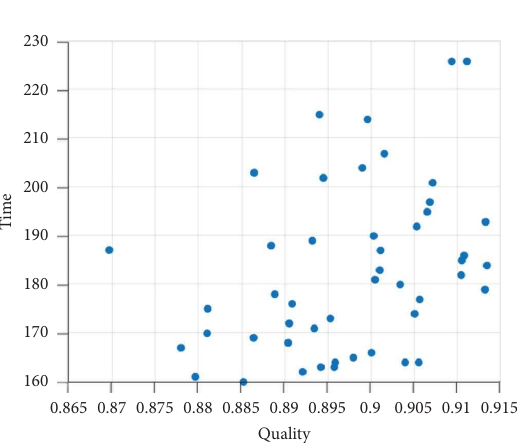
Figure 6: Time-safety trade-of.